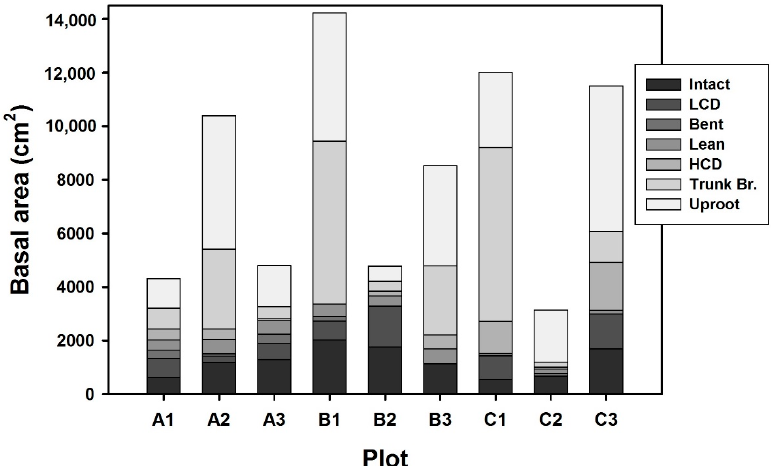
Figure 2. Relative basal area of seven tree damage categories at the Meditation Lake study site. In the figure legend, ‘LCD’ = light crown damage and ‘HCD’ = heavy crown damage; other damage categories are words, not acronyms.